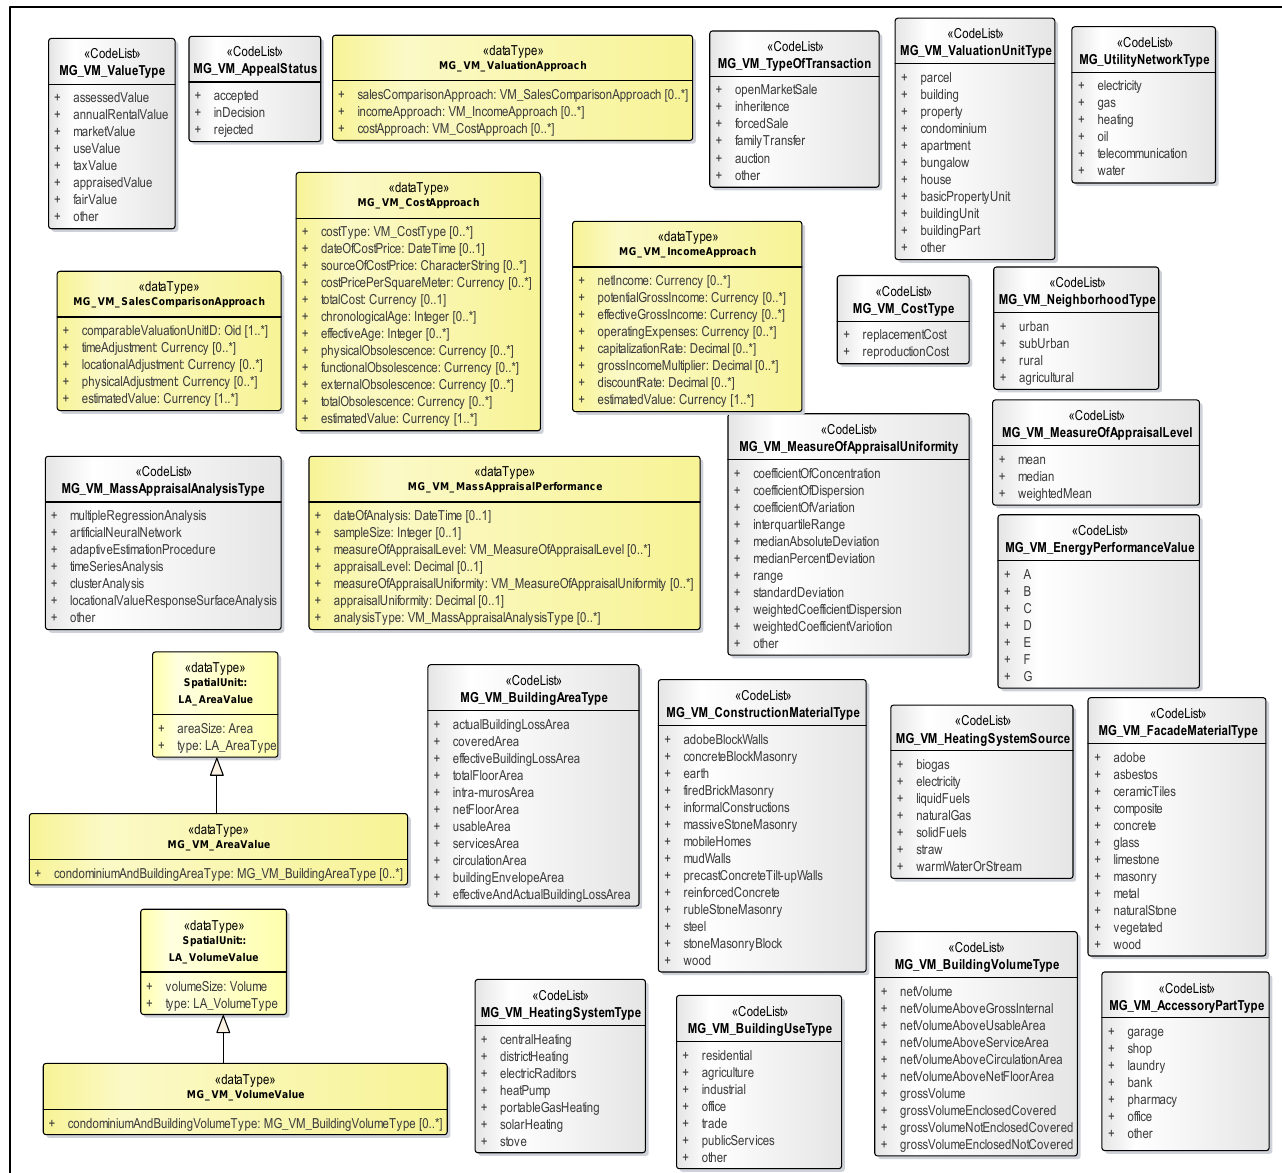
Figure 9. Code lists (in gray) and datatypes (in yellow) of Mongolian LADM Valuation Information Model Country Profile.